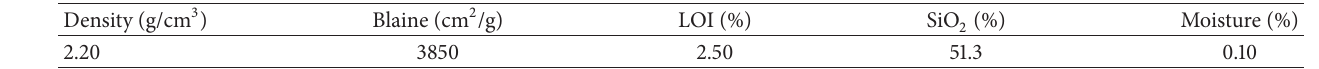
Table 6: Physical properties of fly ash.